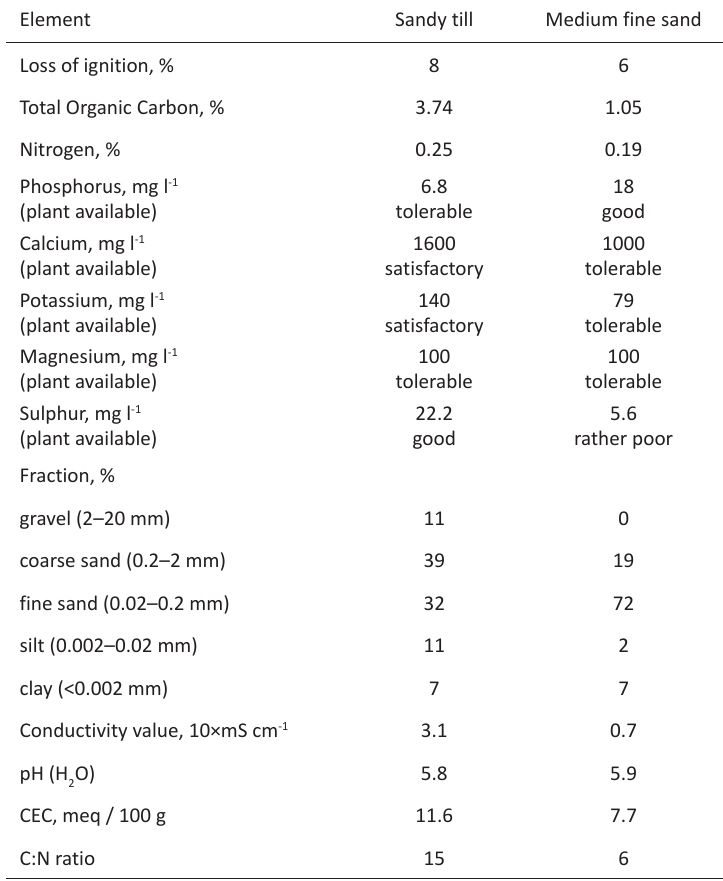
Table 1. Characteristics of the soils used in this study. Fertility classes from lowest to highest nutrient content: poor, rather poor, tolerable, satisfactory, good,